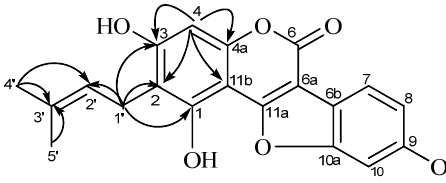
Figure 3. HMBC correlations observed for compound A (demethylglycyrol, 31 ).